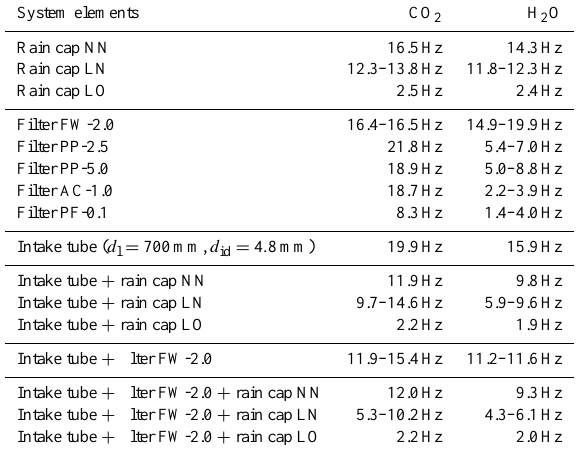
Table 5. CO 2 and H 2 O half-power frequencies for system compo- nents without heating or insulation, for the range of flow rates 9.5 to 14SLmin − 1 , as derived from the data shown in Figs. 3–4. Ranges from multiple experiments are provided when available. Rain caps are NEON new (NN), LI-COR new (LN) and LI-COR old (LO). Fil- ters are Swagelok FW-2.0, 3M/CUNO PP-2.5, 3M/CUNO PP-5.0, Pall AC-1.0 and ZenPure PF-0.1 (Table 2 provides detailed filter